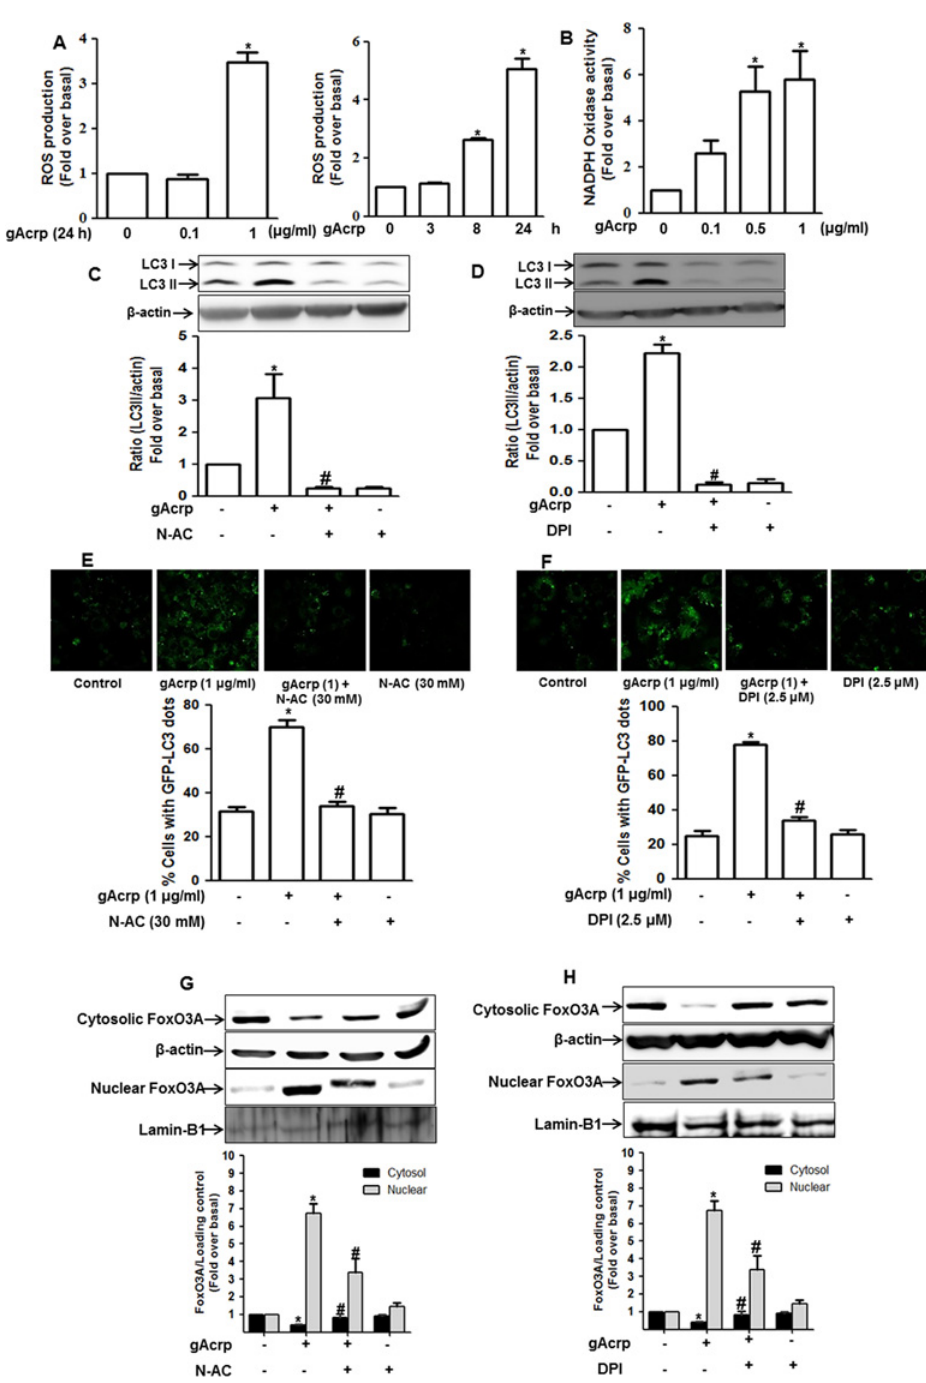
Fig 6. Role of ROS production in gAcrp-induced FoxO3A nuclear translocation and autophagy induction in RAW 264.7 macrophages. (A) Cells cultured in 96-well black plate were treated with different concentration of gAcrp for 24 h (left panel) or 1 μ g/ml of gAcrp for different time duration (right panel). ROS production was determined using fluorometer as described previously. Data represent fold change compared to control cells and are expressed as mean ± SEM (n = 5), * P < 0.05 compared with control. (B) RAW 264.7 macrophages were treated with different concentration of gAcrp for 24 h. NADPH oxidase activity was determined by lucigenin-based assay as described in materials and methods. Values represent fold increase in compared to control cells and are expressed as mean ± S.E.M. (n = 3). * P < 0.05 compared with control cells. (C and D) Cells were pretreated with N-AC (30 mM) (C) or DPI (2.5 μ M) (D) for 1 h, followed